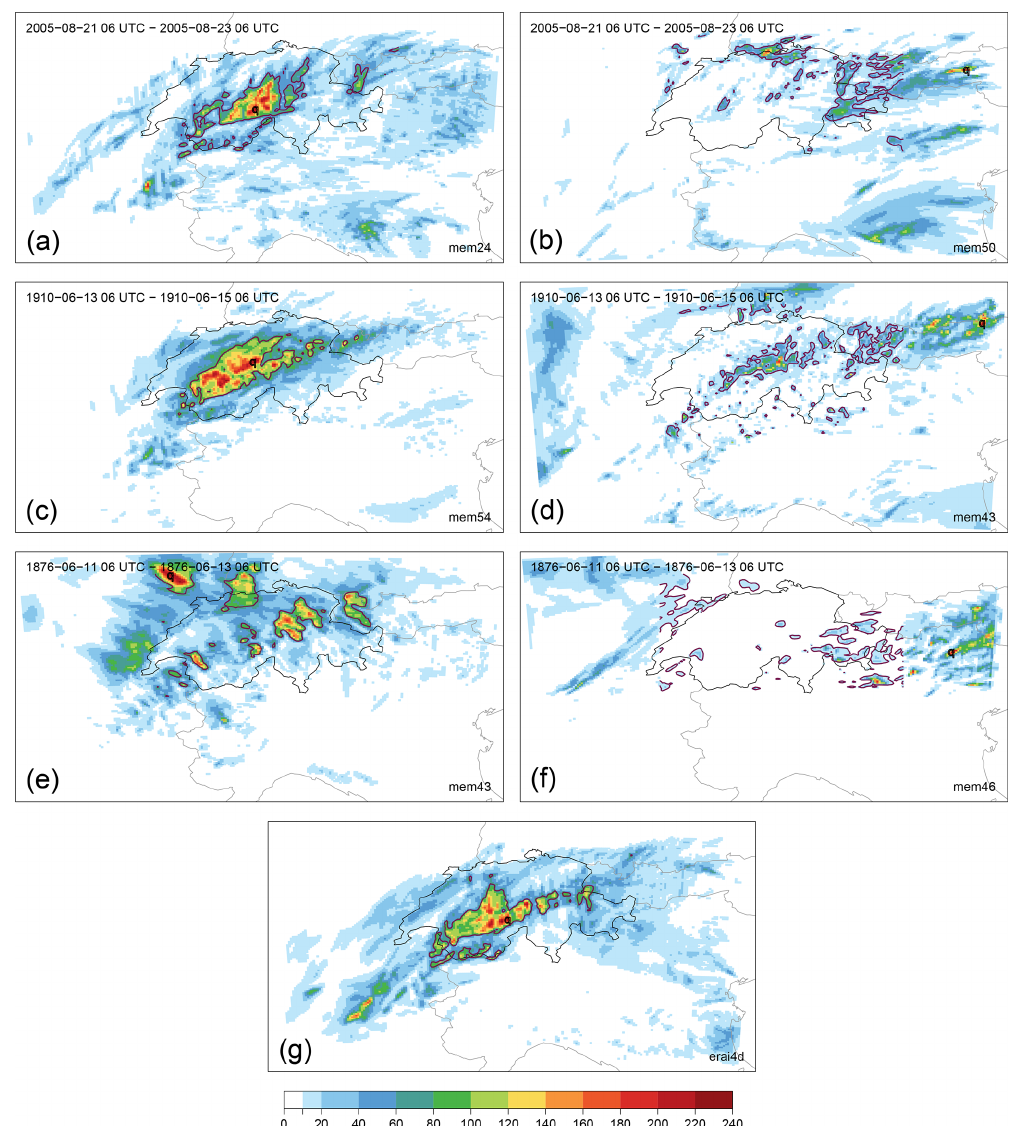
Figure A3. 48h precipitation totals (time periods as in Fig. A1d–f) for (a, c, e) maximum-precipitation members and (b, d, f) minimum- precipitation members for (a, b) the 2005, (c, d) the 1910 and (e, f) the 1876 cases, and for (g) the same simulation setup but with downscaling ERA-Interim for the 2005 case. Precipitation totals may be larger than 240mm in the